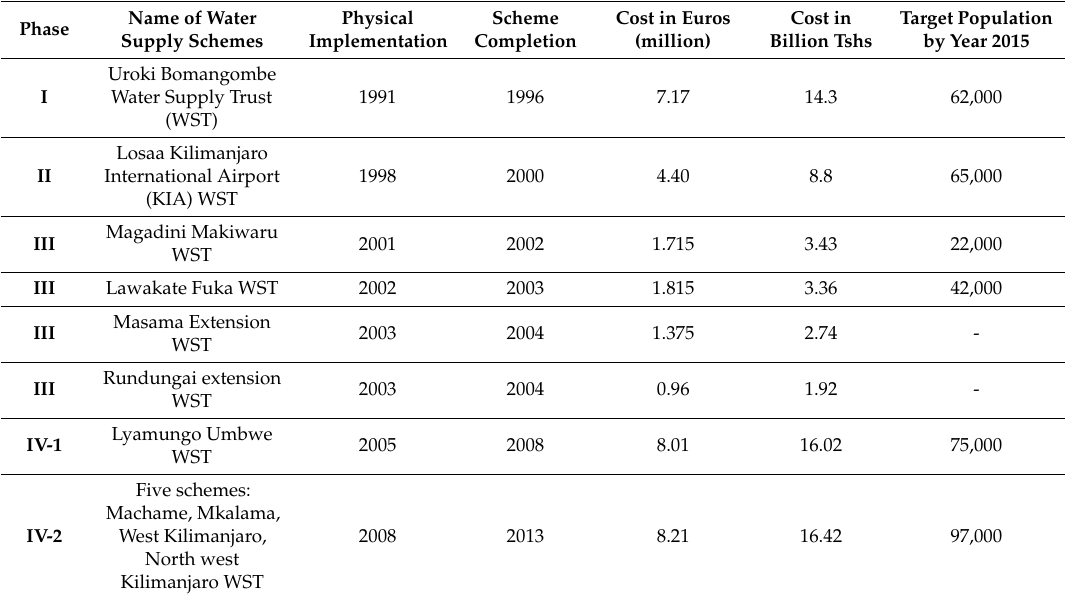
Table 3. Historical trajectory of the financing and implementation of seven Water Trusts in Hai and Siha [Source: Fieldwork data].